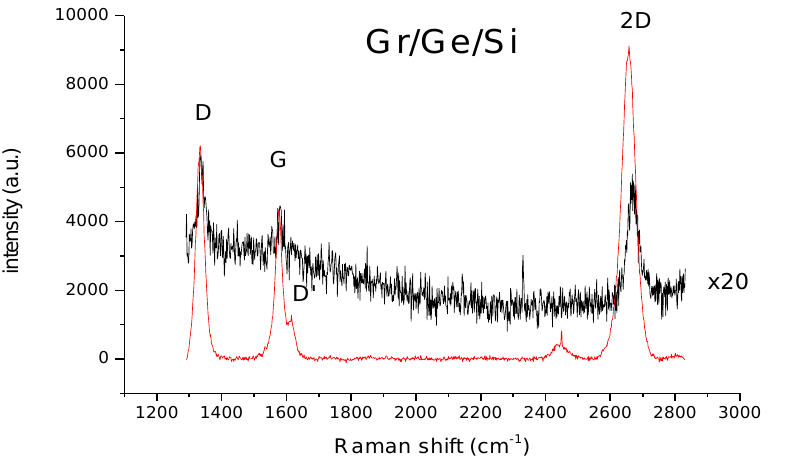
Figure 6. Raman spectra on Gr/Ge/Si(001) (black line) outside the blister multiplied by a factor of 20, and the one on the blister for maximal enhancement (red line).